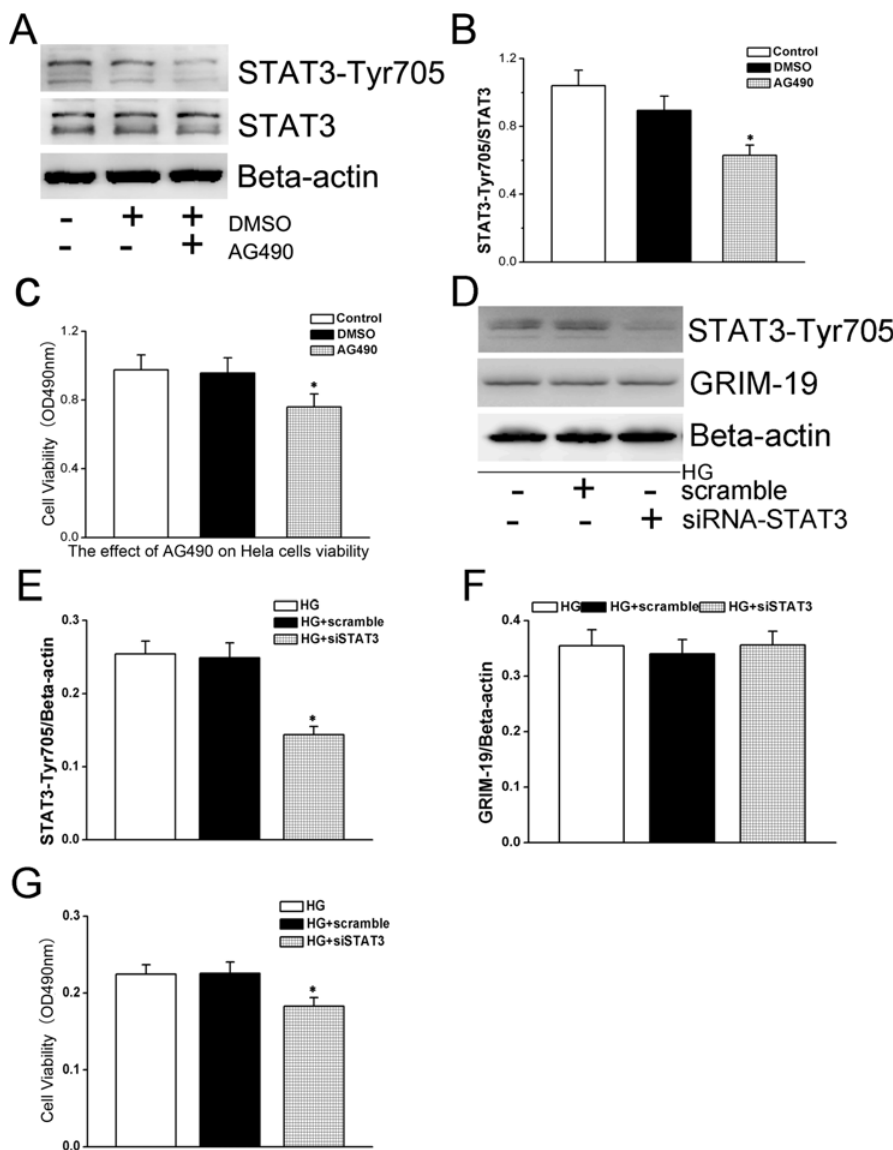
Fig 5. The effects of HG on STAT3 activation were tested when AG490 (40 μ M) was added to the medium (DMSO as a vehicle served as a control). The STAT3-Tyr705 phosphorylation level relative to total STAT3 expression was measured by western blotting (in panel A) where ß-actin served as a loading control, and quantified in bar graph (panel B). Cell proliferation was also measured by the MTT assay (in panel C). HG cultured HeLa cells were also treated with siRNA specially targeting STAT3 with a scramble as a control. The effects of siRNA-STAT3 on phosphorylation of STAT3 were shown in panel D&E and GRIM-19 expression was also quantified in comparison with HG cultured HeLa cells without any interventions (D&F). MTT assay was performed to test the cell proliferation (G). All the data are expressed as mean ± SD (of three independent experiments). * denotes P < 0.05 compared with group either without AG490 or siRNA targeting